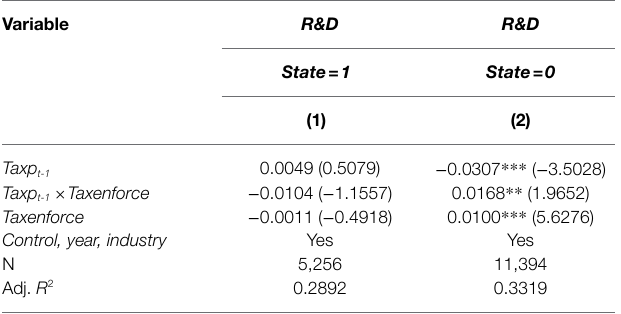
TABLE 5 | Group regression results of the adjustment effect of tax